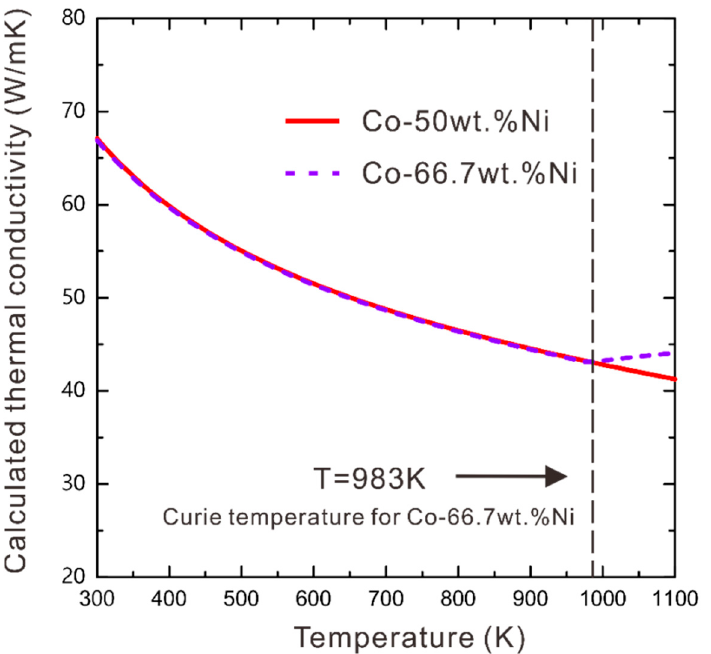
Figure 6. Model-evaluated thermal conductivity of Co-50wt.%Ni and Co-66.7wt.%Ni solid solutions along with the temperature.